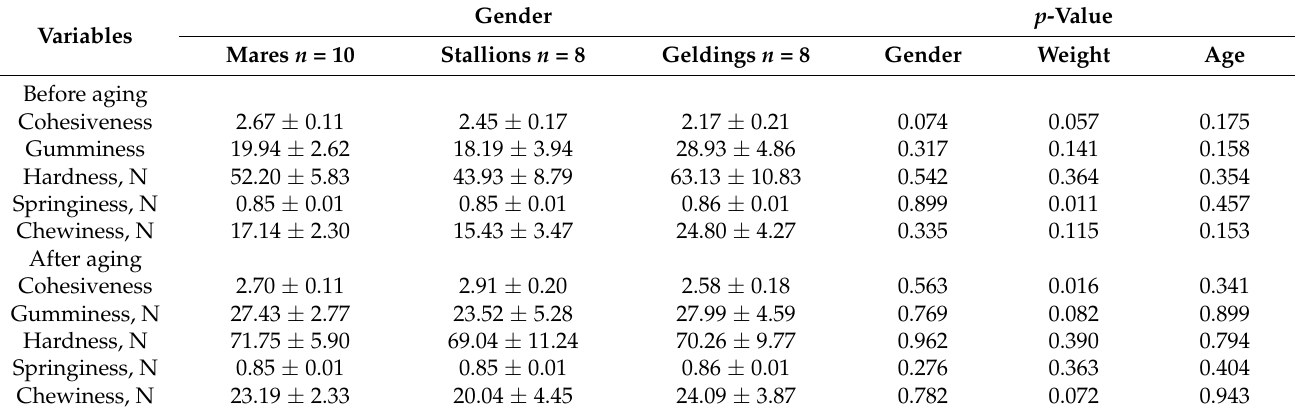
Table 5. Effects of horse gender, age and carcass weight on parameters of texture profile analysis in cooked m . pectoralis profundus muscle before and after aging.